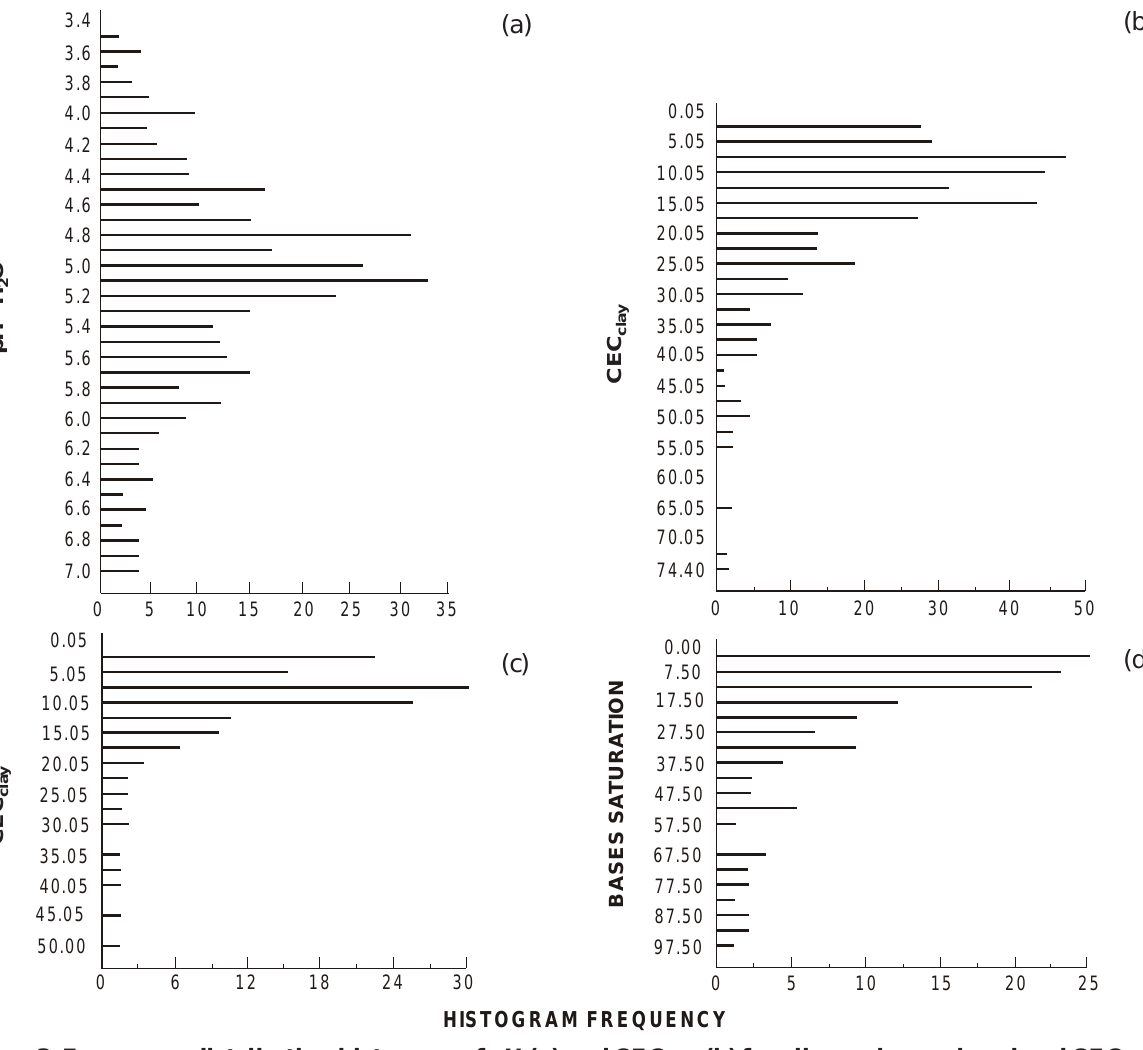
Figure 3. Frequence distribution histogram of pH (a) and CEC (c) and base saturation (d) of soils with Ferralic B